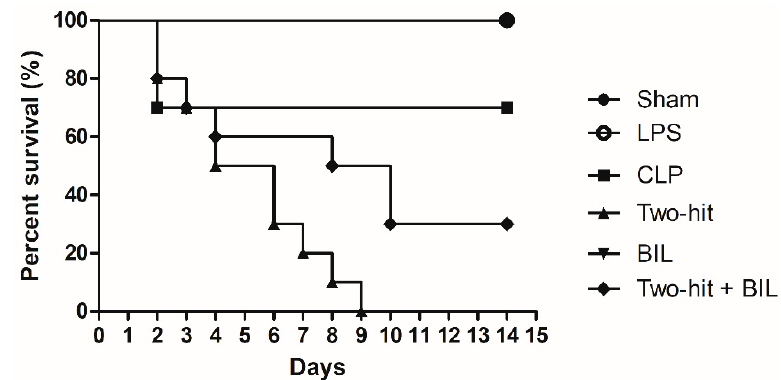
Figure 1. Bilirubin improves survival in the “two-hit” sepsis model. Mice were administered i.p. LPS at 5 mg / kg body weight on day 0. After 24 h, the mice were challenged with cecal ligation and puncture (CLP: 25-gauge needle and double-puncture). Next, the mice were administered bilirubin at 30 mg / kg body weight. The mice were observed for 15 days after LPS or saline was injected ( n = 10 mice per group) and analyzed by Kaplan–Meier plots with log-rank tests. p < 0.001 two-hit group versus sham, LPS and BIL group. p < 0.01 two-hit group versus CLP group. p < 0.001 two-hit + BIL group versus BIL group. p = 0.040 in the “Two-hit” group versus two-hit + BIL group. LPS: lipopolysaccharide, CLP: cecal ligation and puncture, BIL: